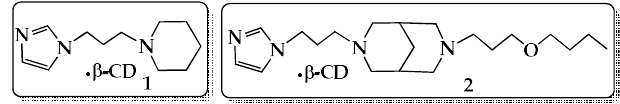
Figure 1. Complexes of 3-(1 H -imidazol-1-yl)propyl derivatives.